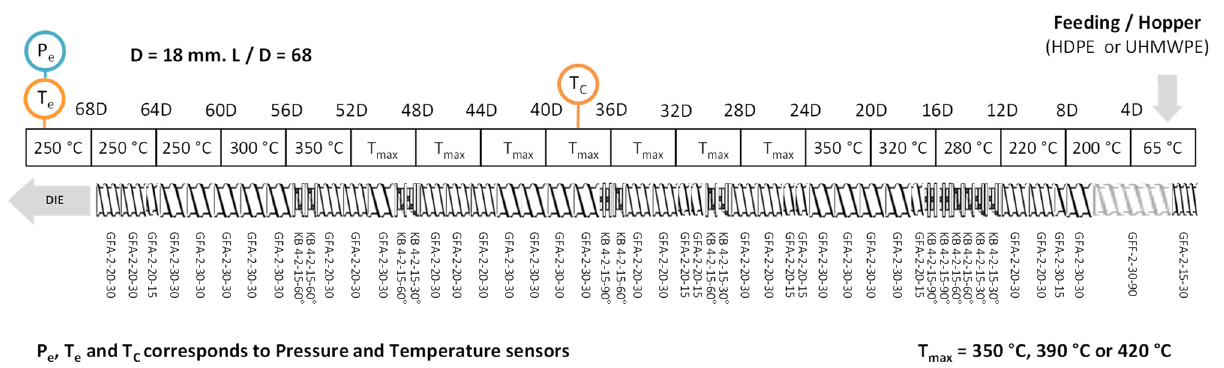
Figure 3. Scheme of the screw and temperature profiles used.